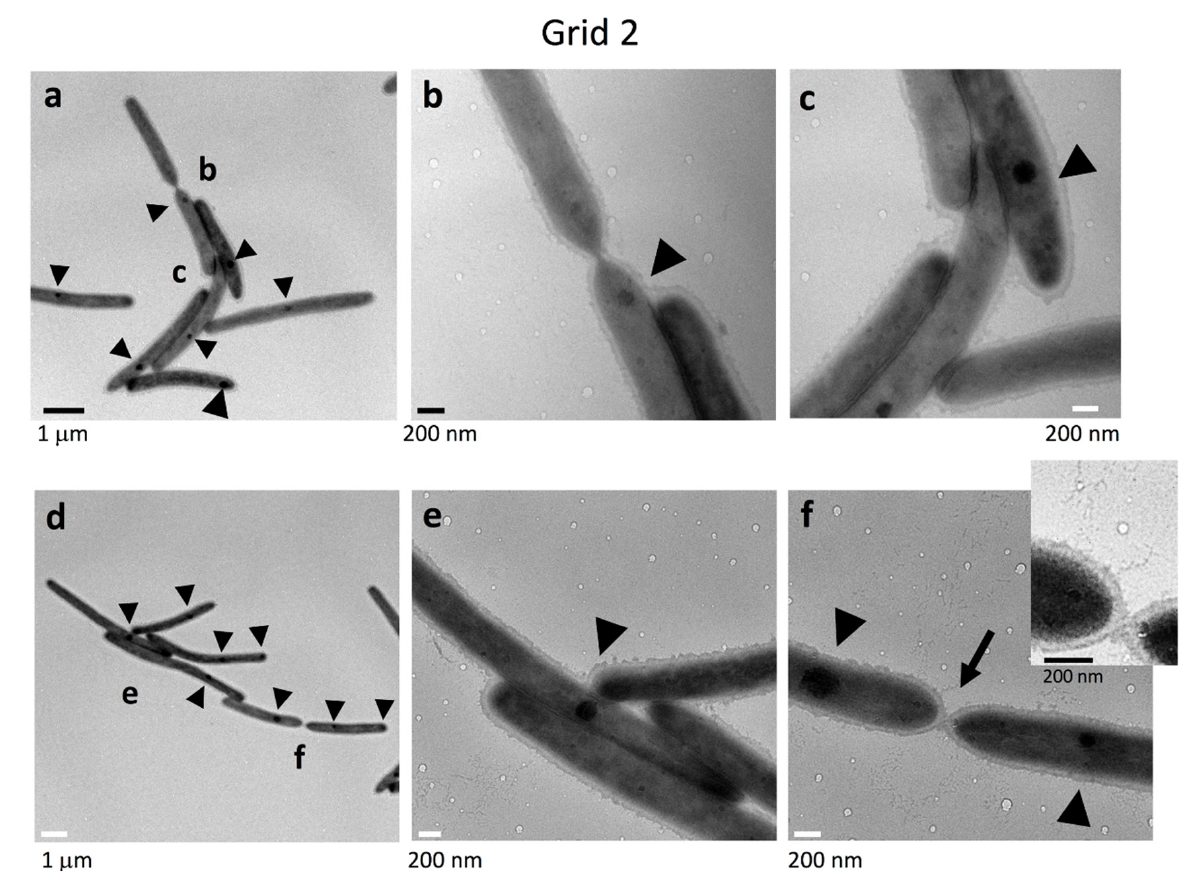
Figure 3. Cell connections at the translucent edge of a typical spreading WT colony. The colony surface was sampled using the grid stamp method at Grid position 2 (Figure 1b), and connections between cells in clusters were imaged by negative- stain TEM. ( a ) Low magnification image. ( b , c ) Higher magnification images of the annotated areas in ( a ). ( d – f ) Another cell cluster. ( d ) Low magnification image. ( e , f ) Higher magnification images of the annotated areas in ( d ). ( f ) Many cells made head-to-tail and/or side-to-side contacts. Inset: enlargement (1.7 × ) of the connection indicated by an arrow. The area surrounding cells was covered by poorly stained filamentous matrices and vesicles as shown in ( f ). Dark spots of high electron density in the cells are indicated by arrowheads. One or two dark spots of high electron density are distinguishable for each cell.